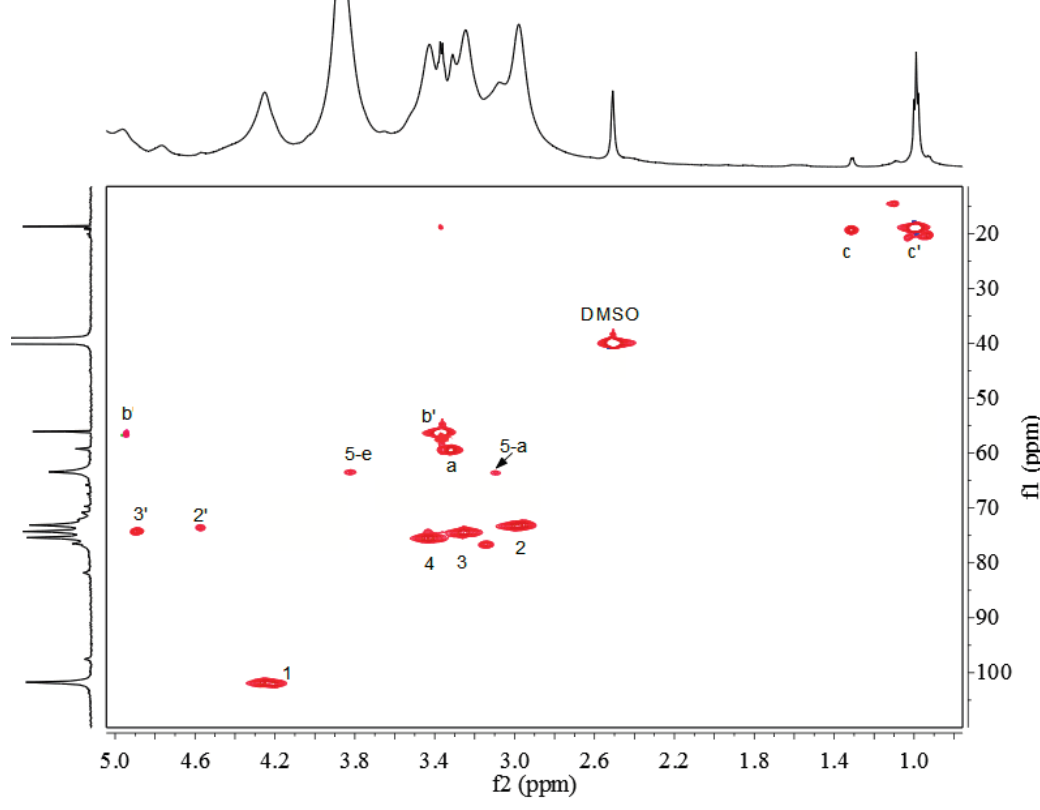
Figure 4. HSQC spectrum of xylan- g -PPC copolymer sample 12 (DS =